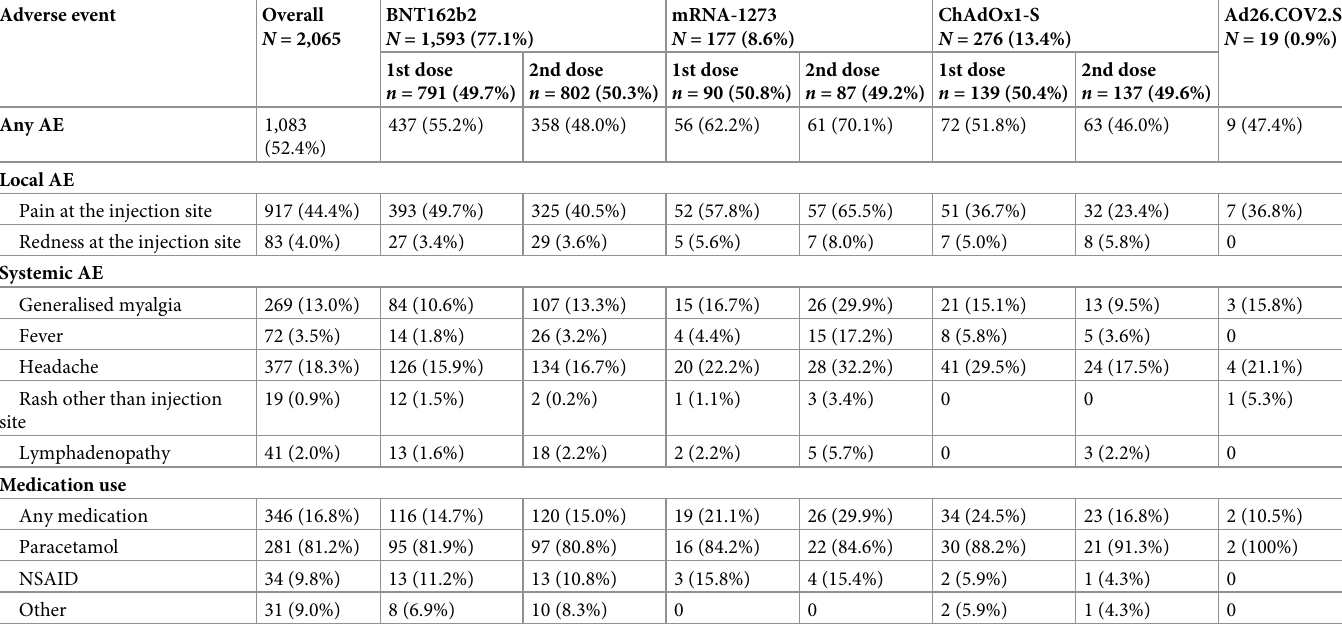
Table 2. Reactogenicity in